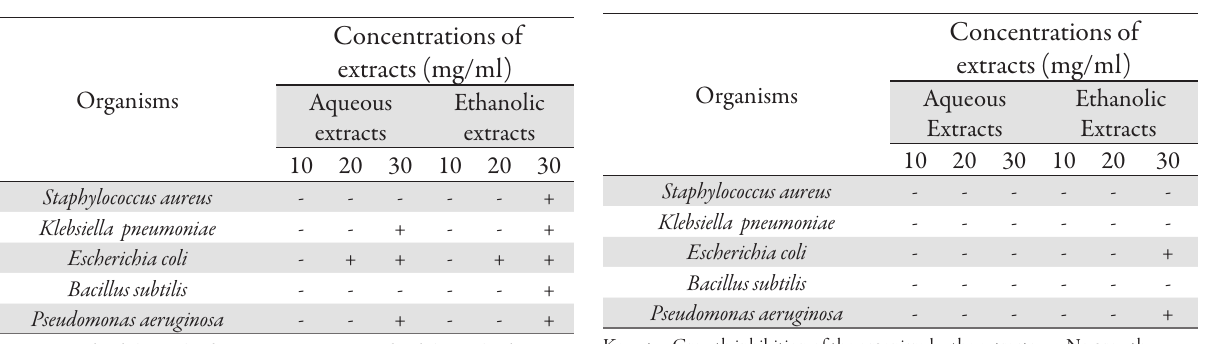
Tab. 5. The bactericidal effects of aqueous and ethanolic